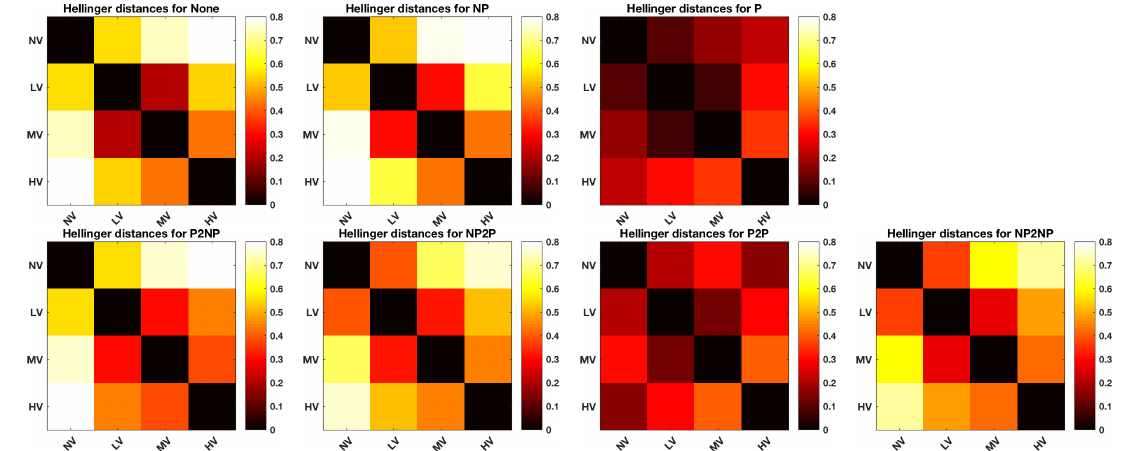
Figure 5. Hellinger distances between the PDFs of all vegetation states and for all precipitation